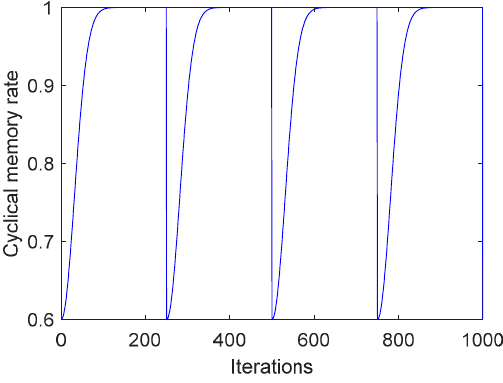
Figure 1. The cyclical memory rate curve.